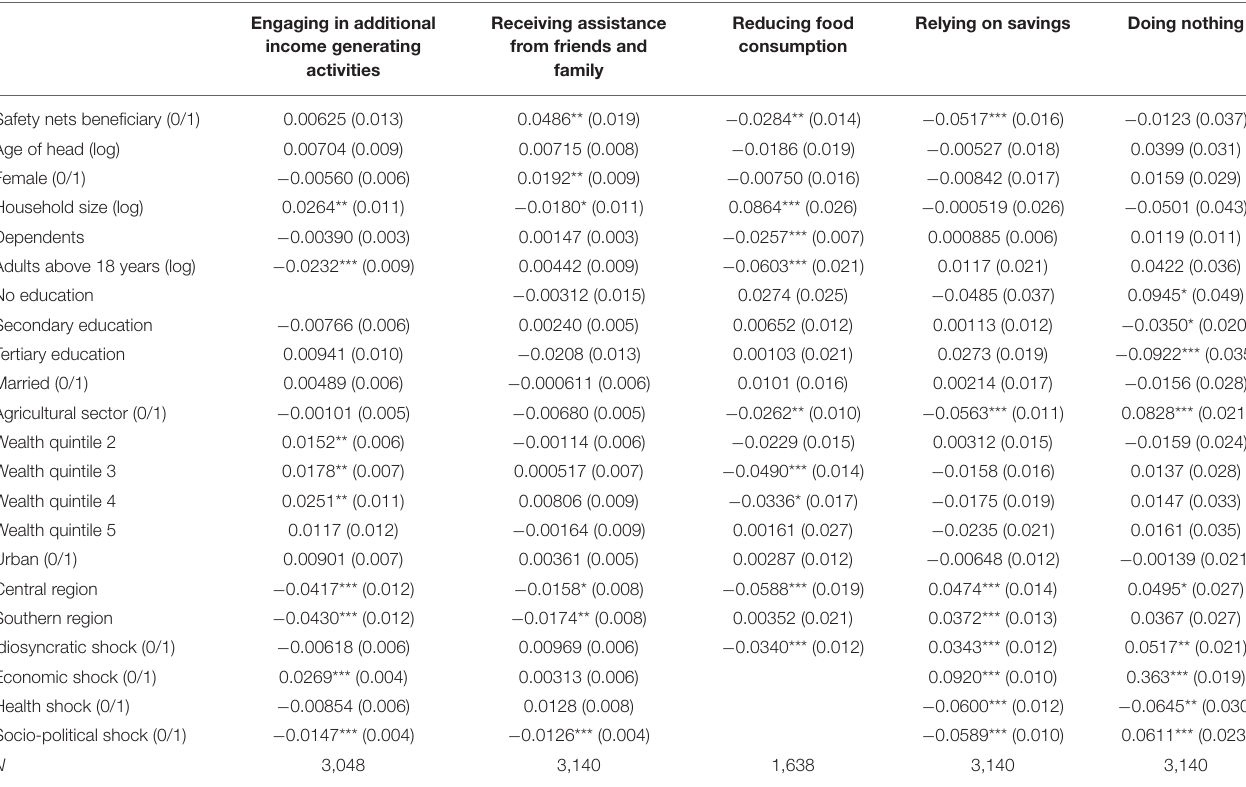
TABLE 4 | Marginal effects-overall probit